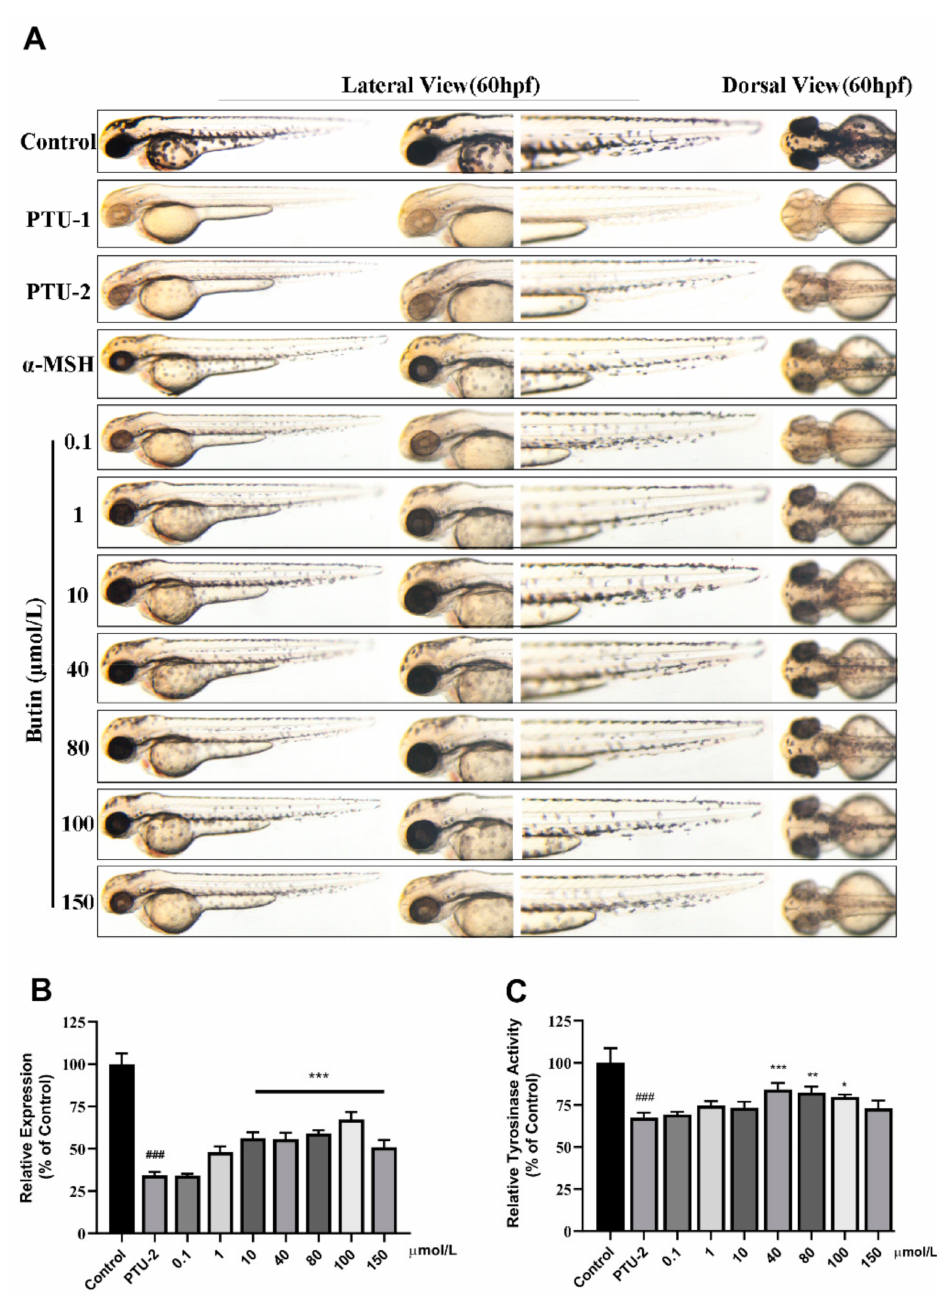
Figure 4. Effect of butin on melanogenesis in vivo. ( A ) Zebrafish melanin phenotype in various concentrations of butin [0.1, 1, 10, 40, 80, 100 and 150] µ mol · L − 1 , the α -MSH is 60 µ mol · L − 1 , and the PTU-1 group was not washed at all while the PTU-2 group was washed before administration. The control, PTU-1, PTU-2 and α -MSH groups share with caffeic acid and luteolin. ( B ) Collecting zebrafish in each group for testing melanin content (relative expression % of control). ( C ) Tyrosinase activity in zebrafish exposure to butin for 24 h. In ( B , C ), results shown are mean ± SEM. Data were analyzed by ANOVA followed by post hoc Tukey test. n = 30 zebrafish, ### p < 0.001 vs. Control, *** p < 0.001, ** p < 0.01, * p < 0.05 vs.